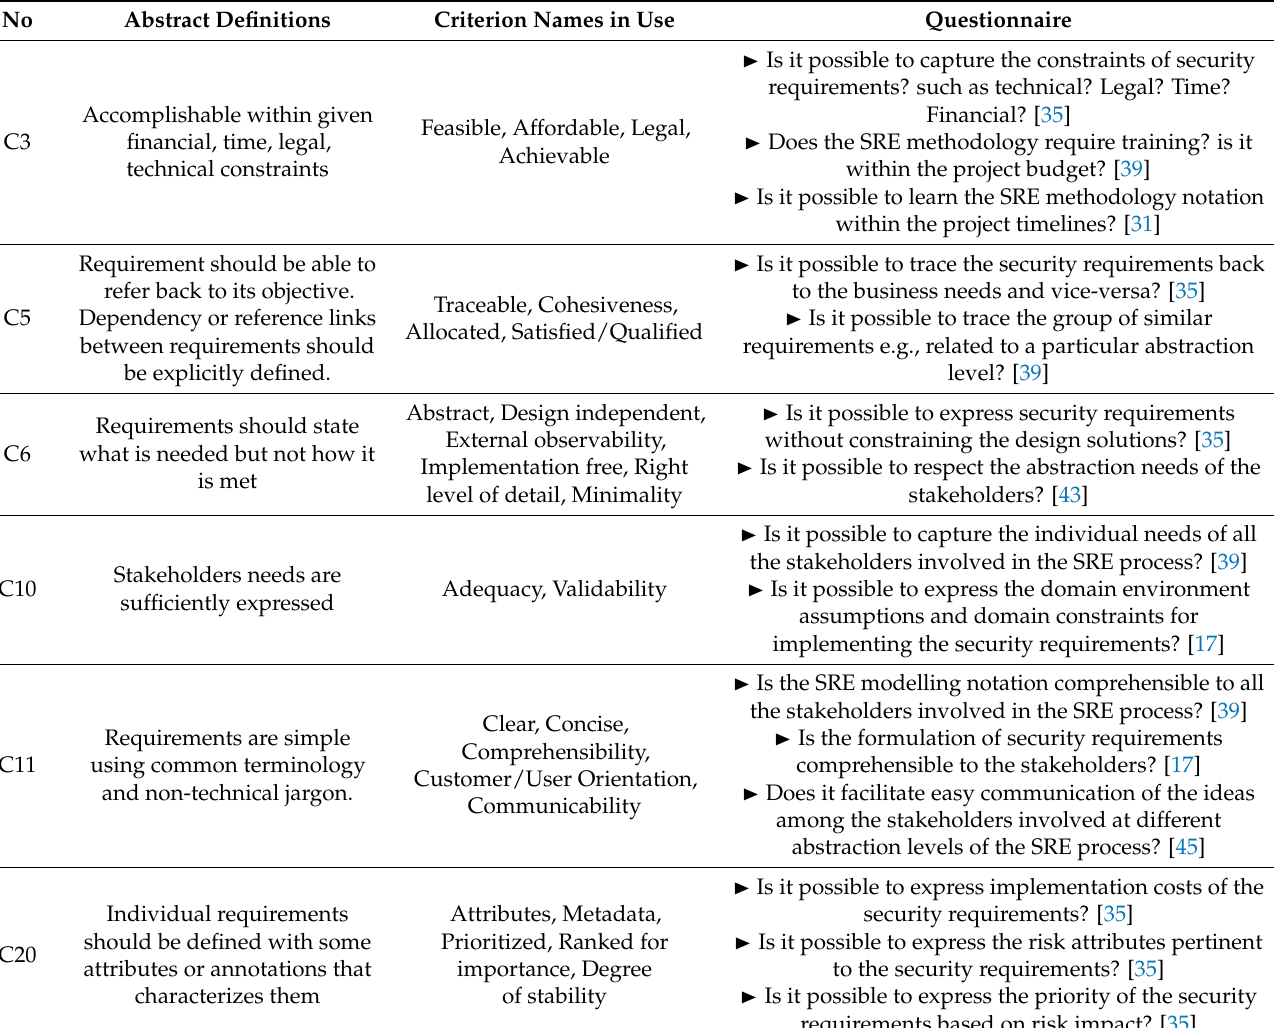
Table 3. Elicitation tool